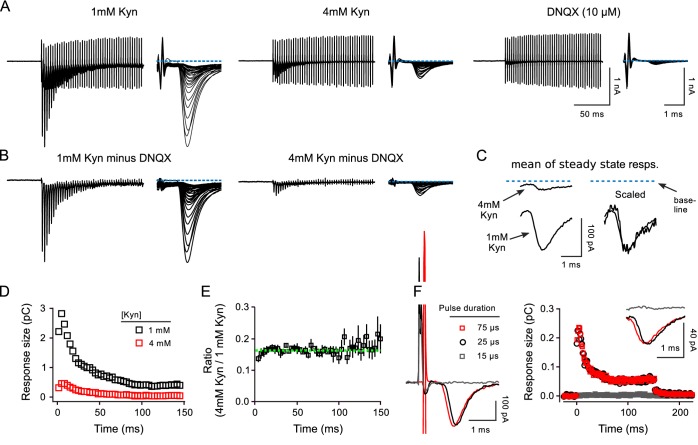
Controls for receptor desensitization and spill over at calyx of Held. (A-E) Comparison of postsynaptic responses during 300 Hz stimulation in 1 vs in 4 mM kynurenic acid at QKO synapses. (A) Responses in 1 and 4 mM kynurenic acid, and in 10 μM DNQX. (B) Differential responses generated by subtracting the trace recorded in DNQX. (C) Mean of responses during steady state achieved after inducing depression. No difference was detected in either the phasic or tonic components in 1 vs 4 mM kynurenic acid. The tonic component is likely caused by so-called asynchronous release, which is evoked vesicular glutamate release that is only loosely coupled in time to the evoking action potentials, and occurs more often during high-frequency stimulation when the residual Ca2+ level is high (Atluri and Regehr, 1998; Sakaba, 2006). (D and E) No difference in 1 vs 4mM kynurenic acid in the measures of short-term plasticity used in the main manuscript for calyx of Held synapses. (D) Current integral measurements for traces in (B). (E) Quantification from n = 3 preparations (mean ± s.e.m.; all QKO). Green dashed line is the mean value of all data points. The small deviation of the first one or two data points indicates that 4 mM kynurenic acid blocked the response to the first pulse of stimulation by slightly more than subsequent responses. The cause of the deviation is not known, but likely does not involve AMPA receptor desensitization, which would be expected to affect later responses more than earlier responses. In any case, the effect was not enough to alter estimates of the timing of vesicle recruitment. A similar effect was seen at WT synapses (not shown). Results in (D–E) rule out a substantive contribution of receptor desensitization to our calyx of Held measurements by the following logic: (i) kynurenic acid prevents receptor desensitization by preventing activation; (ii) switching from 1 to 4mM decreases response size and therefore receptor occupancy by 7-fold and would therefore reduce the amount of desensitization by a large amount, which would alter short-term plasticity; (iii) thus, the absence of substantive alterations in short-term plasticity indicates that receptor desensitization did not play a role when synapses were bathed in 1 mM kynurenic acid, or more. Note that the situation may be different in tissue from younger animals (Neher and Sakaba, 2001). (F) Comparison of postsynaptic responses during 300 Hz stimulation when the duration of stimulation pulses was: just above threshold (black); 3X higher (red); and just below threshold (gray). Kynurenic acid was 2 mM. The traces to the left are the responses to the first pulses of stimulation. Traces in the inset are the mean traces when the synapses are in a depressed steady state. These results argue against a contribution of neurotransmitter spill over from nearby synapses to the steady state response.